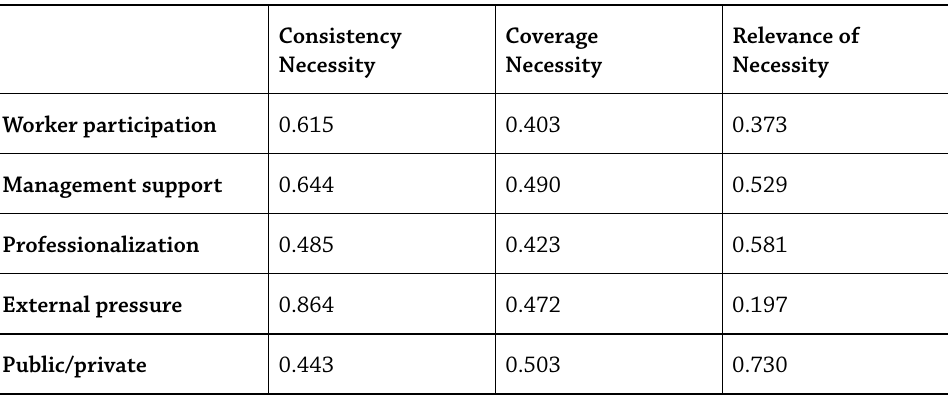
Table 8: Necessary conditions for